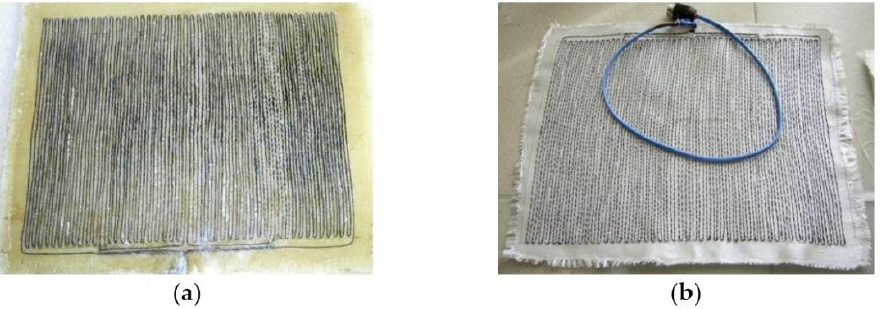
Figure 10. Heated moulding tool ( a ) and resistive layer based on carbon thread and fiberglass ( b ).